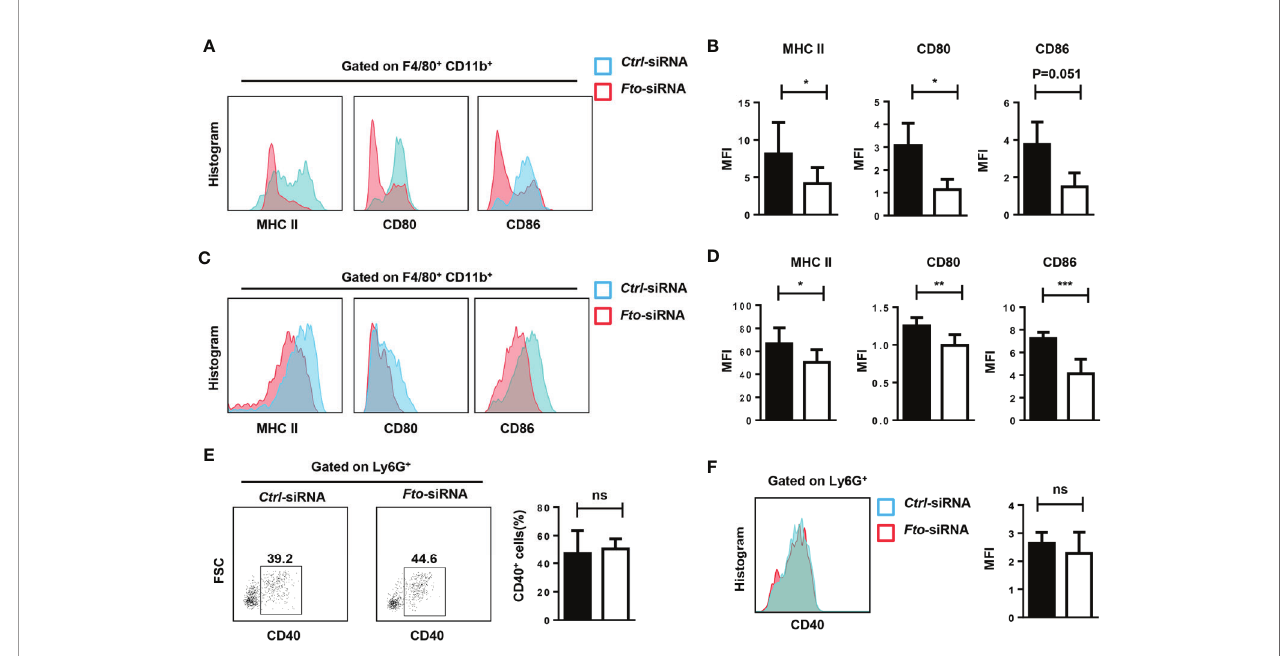
FIGURE 4 | Fto knock down attenuates macrophage activation in LPS induced-septic shock. The peritoneal cells (A, B , E) and splenocytes (C, D , F) were harvested 6 h after intraperitoneal injection of LPS. (A – D) Representative fl ow cytometry data for analysis of CD80, CD86 and MHC II expression in macrophages, and the mean fl uorescence intensity (MFI) values of MHC II,CD80 and CD86 and the expression in F4/80 + CD11b + macrophages are shown as bar graphs. (E, F) Representative fl ow cytometry data for analysis of CD40 expression in neutrophils, and the mean fl uorescence intensity values of CD40 expression in Ly6G + neutrophils are shown in bar graphic fi gures. Data are shown as mean ± SEM; *P < 0.05; **P < 0.01; ***P < 0.001 (two-tailed unpaired t-test). ns, not signi fi cant.